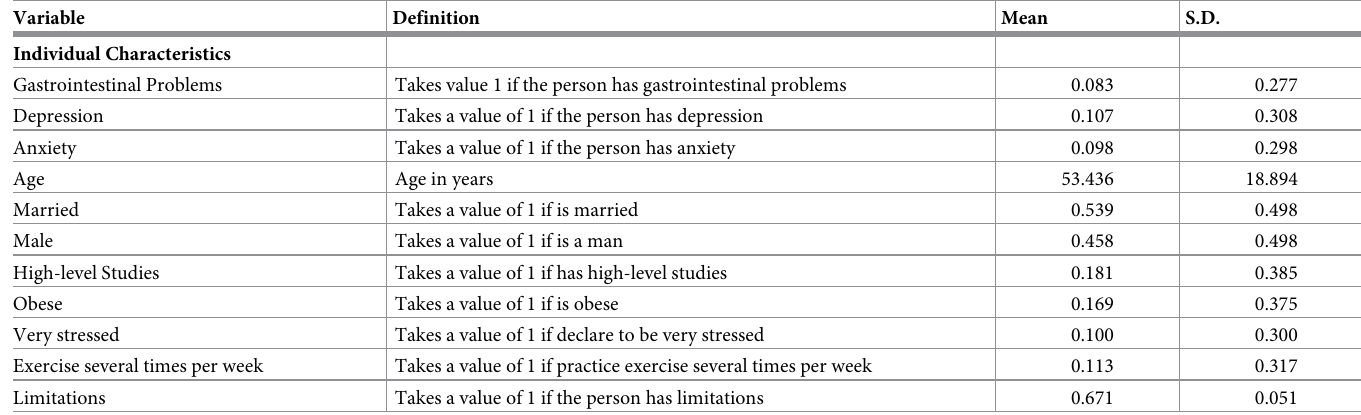
Table 1. Main statistics.